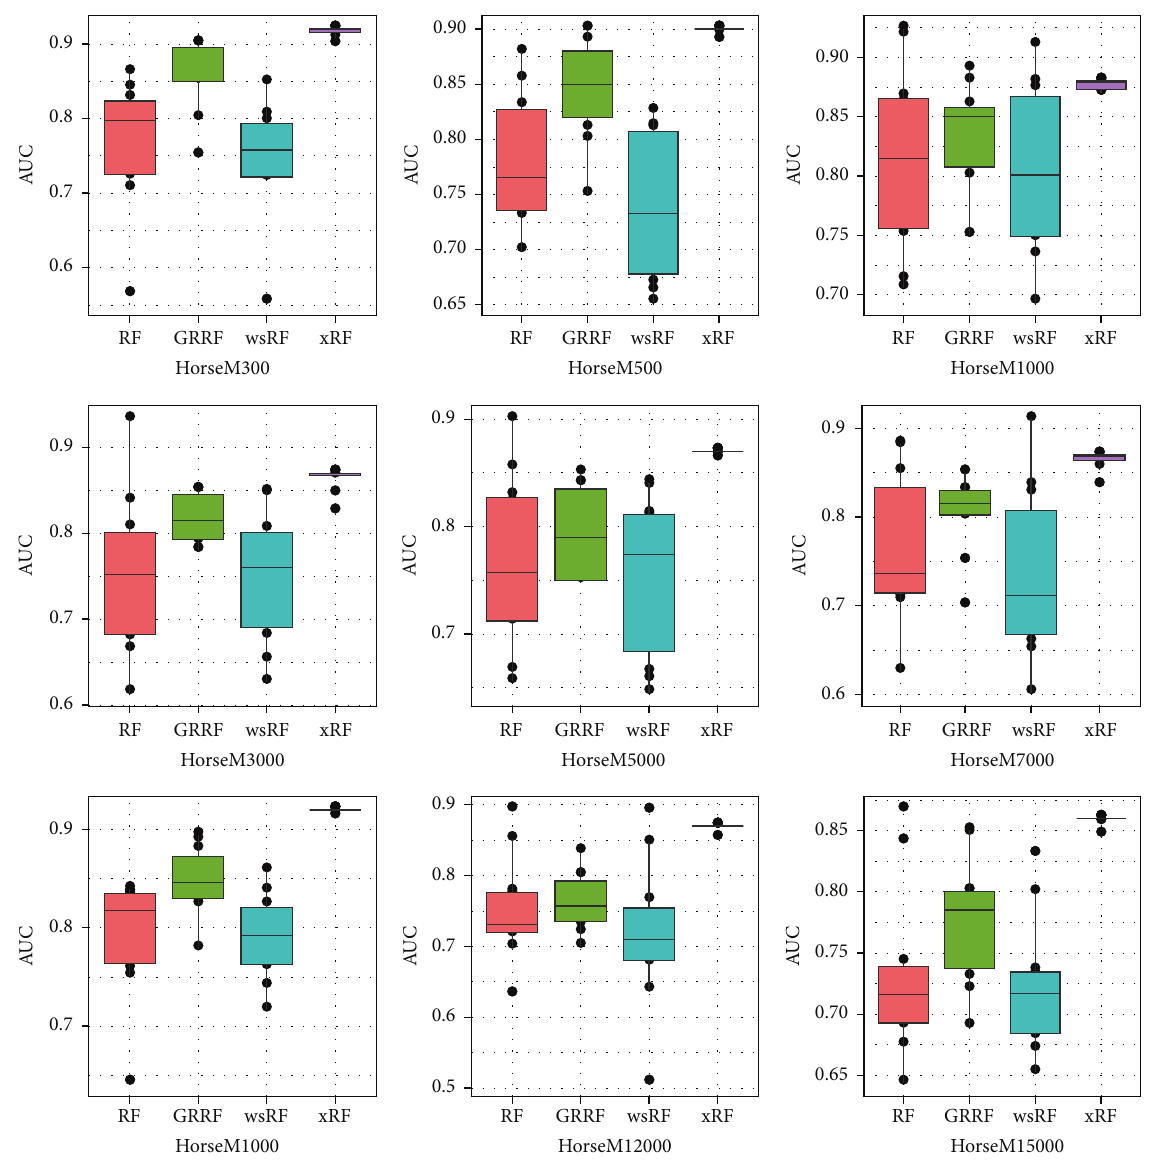
Figure 6: Box plots of the AUC measures of the nine Horse